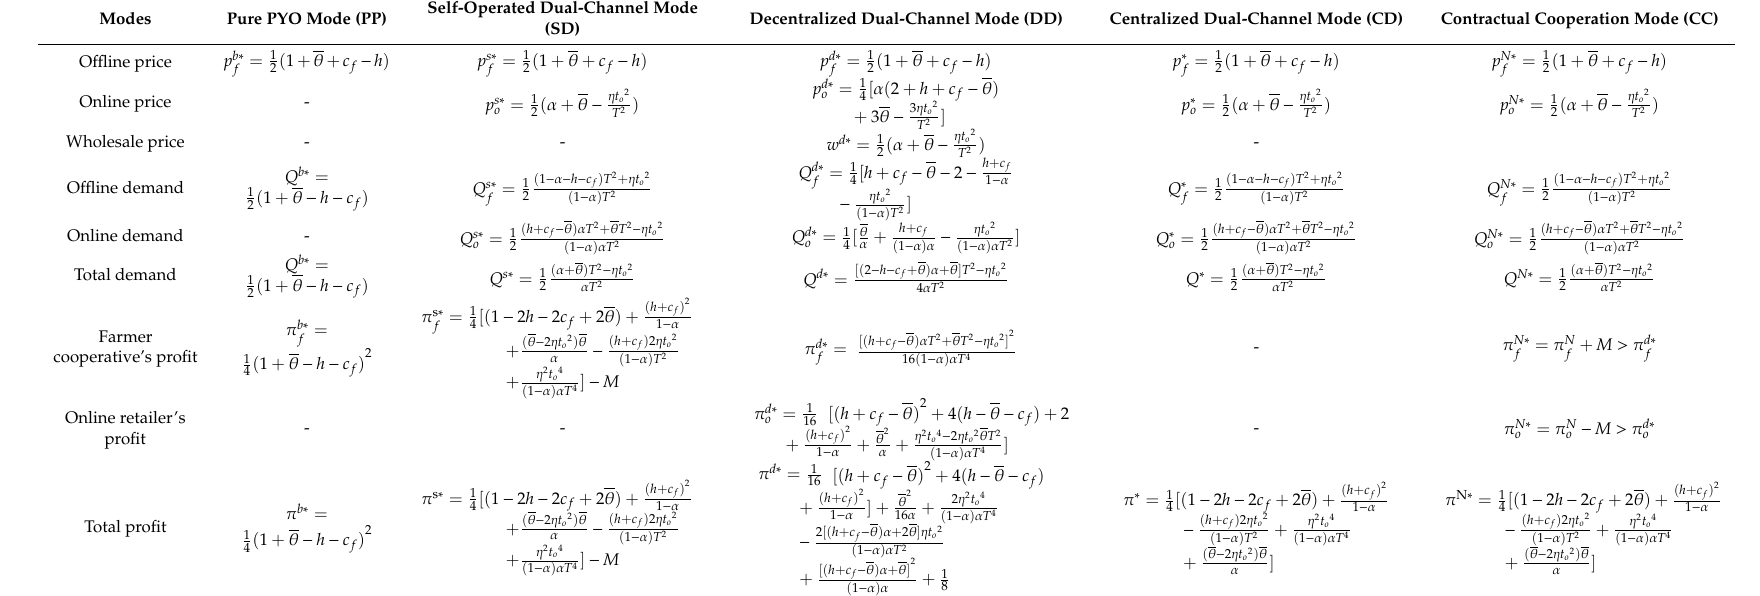
Table 3. Optimal decisions of five